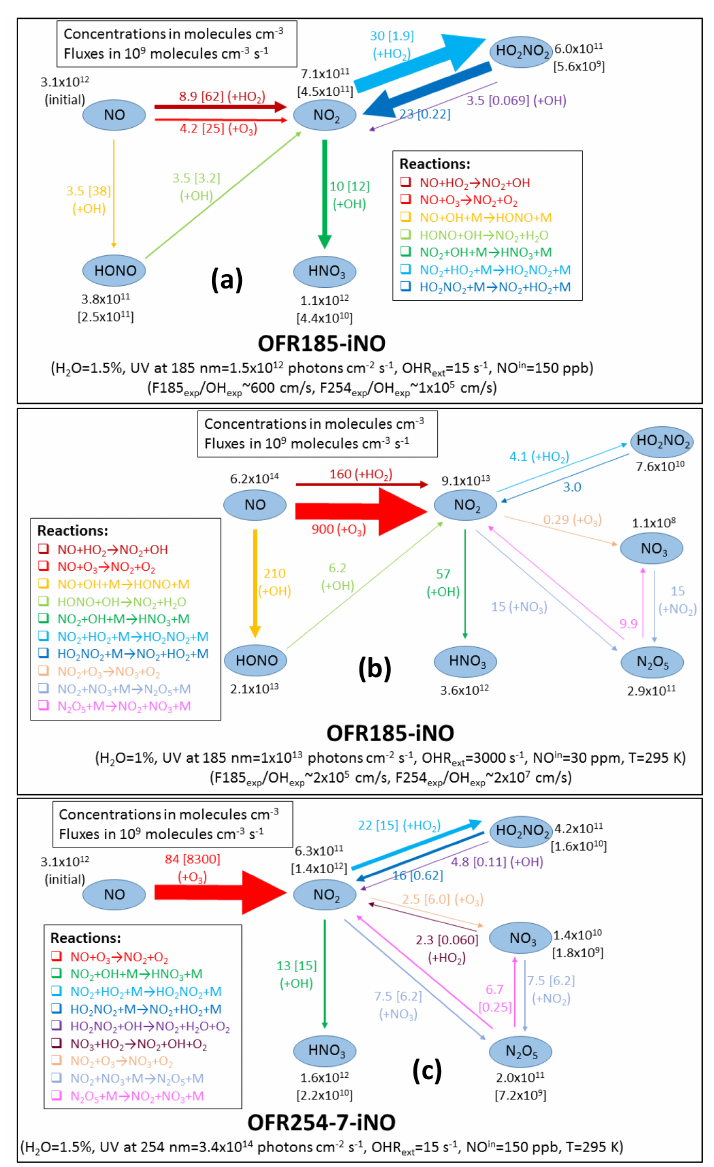
Figure 1. Schematics of main N-containing species and their major interconversion pathways under typical input conditions for (a) OFR185- iNO with NO in = 150ppb, (b) OFR254-7-iNO with NO in = 150ppb, and (c) OFR185-iNO with NO in = 30ppm. Species average concentra- tions (in moleculescm − 3 ) are shown in black beside species names. Arrows denote directions of the conversions. Average reaction fluxes (in units of 10 9 moleculescm − 3 s − 1 ) are calculated according to the production rate and shown on or beside the corresponding arrows and in the same color. Within each schematic, the thickness of the arrows is a measure of their corresponding species flux. Multiple arrows in the same color and pointing to the same species should be counted only once for reaction flux on a species. Note that all values in these schematics are average ones over the residence time, except for those in square brackets in panels (a) and (b) , which are average values within approximate NO effective lifetime ( τ NO , or more accurately, an integer multiple of the model’s output time step closest to NO effective lifetime). All concentrations and fluxes have two significant